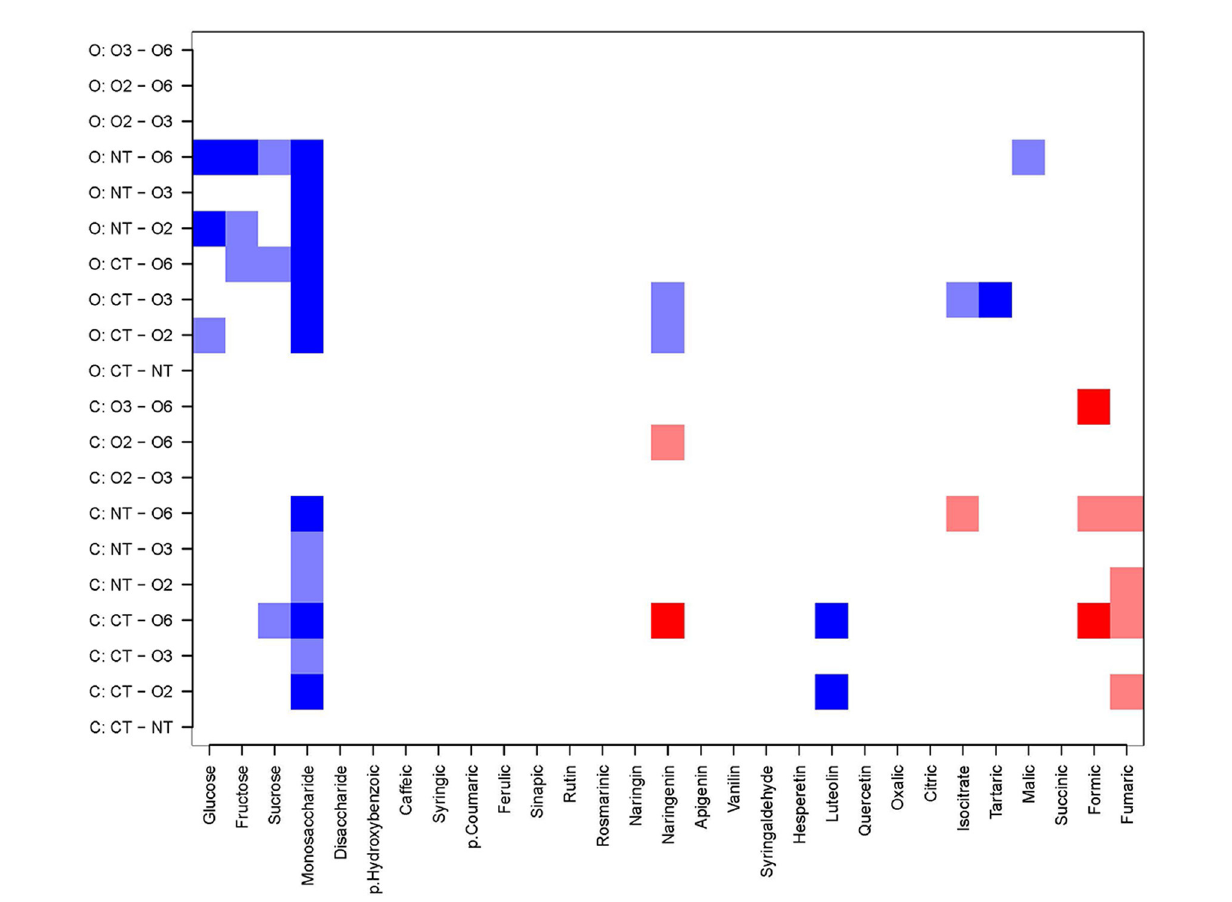
FIGURE1 Heat map giving contrast results for metabolite compounds (x-axis) for the two different maize varieties (organic, conventional) grown under various systems (y-axis). Blue squares are contrasts where the mean levels of the metabolite are significantly higher for the first system of the pair, at p < 0.01 for dark blue, and 0.01 < p < 0.05 for light blue. Red squares are contrasts where the mean levels of the metabolite are significantly higher for the second system of the pair, at p < 0.01 for dark red, and 0.01 < p < 0.05 for light red. O, Organic maize variety; C, Conventional maize variety; O2, Org2 or 2-year organic rotation; O3, Org3 or 3-year organic rotation; O6, Org6 or 6-year organic rotation; NT, 3-year conventional no-till rotation; CT, 3-year conventional tillage rotation. See materials and methods for more details.